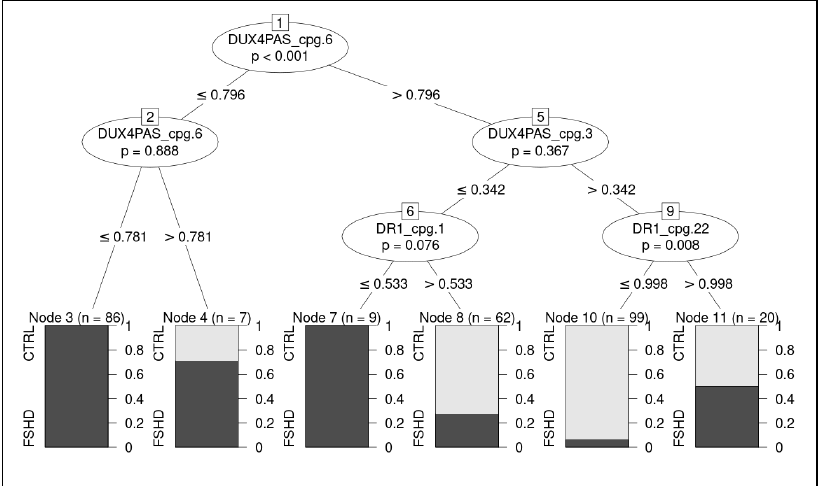
Figure 5. Illustration of the decision tree showing the hierarchical order of decisions to discriminate between groups . The considered CpG sites are highlighted with relative decision thresholds based on methylation levels. The boxes report predicted class, relative proportion of subjects belonging to the group (CTRL and FSHD, respectively) and number of classified subjects per node. The p -values refers to permutation test of the